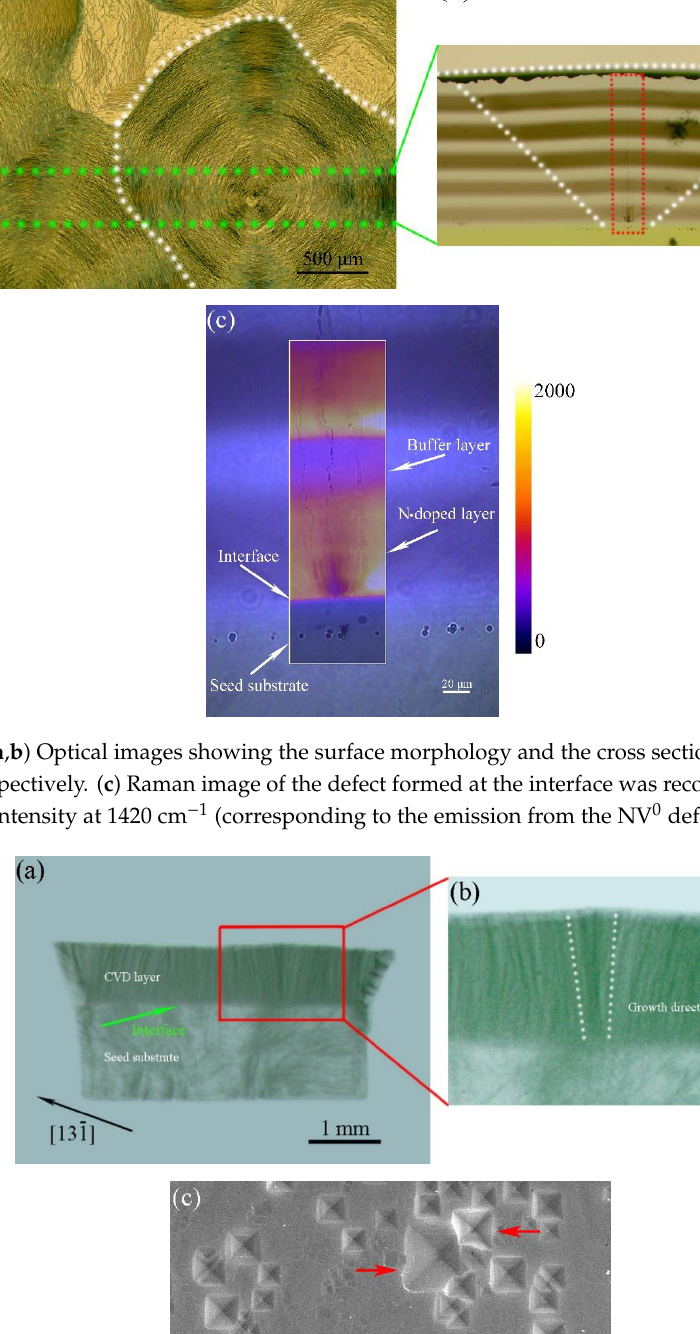
Figure 6. ( a ) XRT image of the (100)-cut slice of the sample 1 showing the interface between the HPHT seed substrate and the CVD layer, which is indicated by the green arrow. ( b ) Magnified XRT image of the pyramidal feature. The image shows that a number of dislocations are formed at the defect, and some of the dislocations are bent along the direction of the step flow. ( c ) Optical microscope image of surface morphology of the HPHT seed substrate after plasma etching.